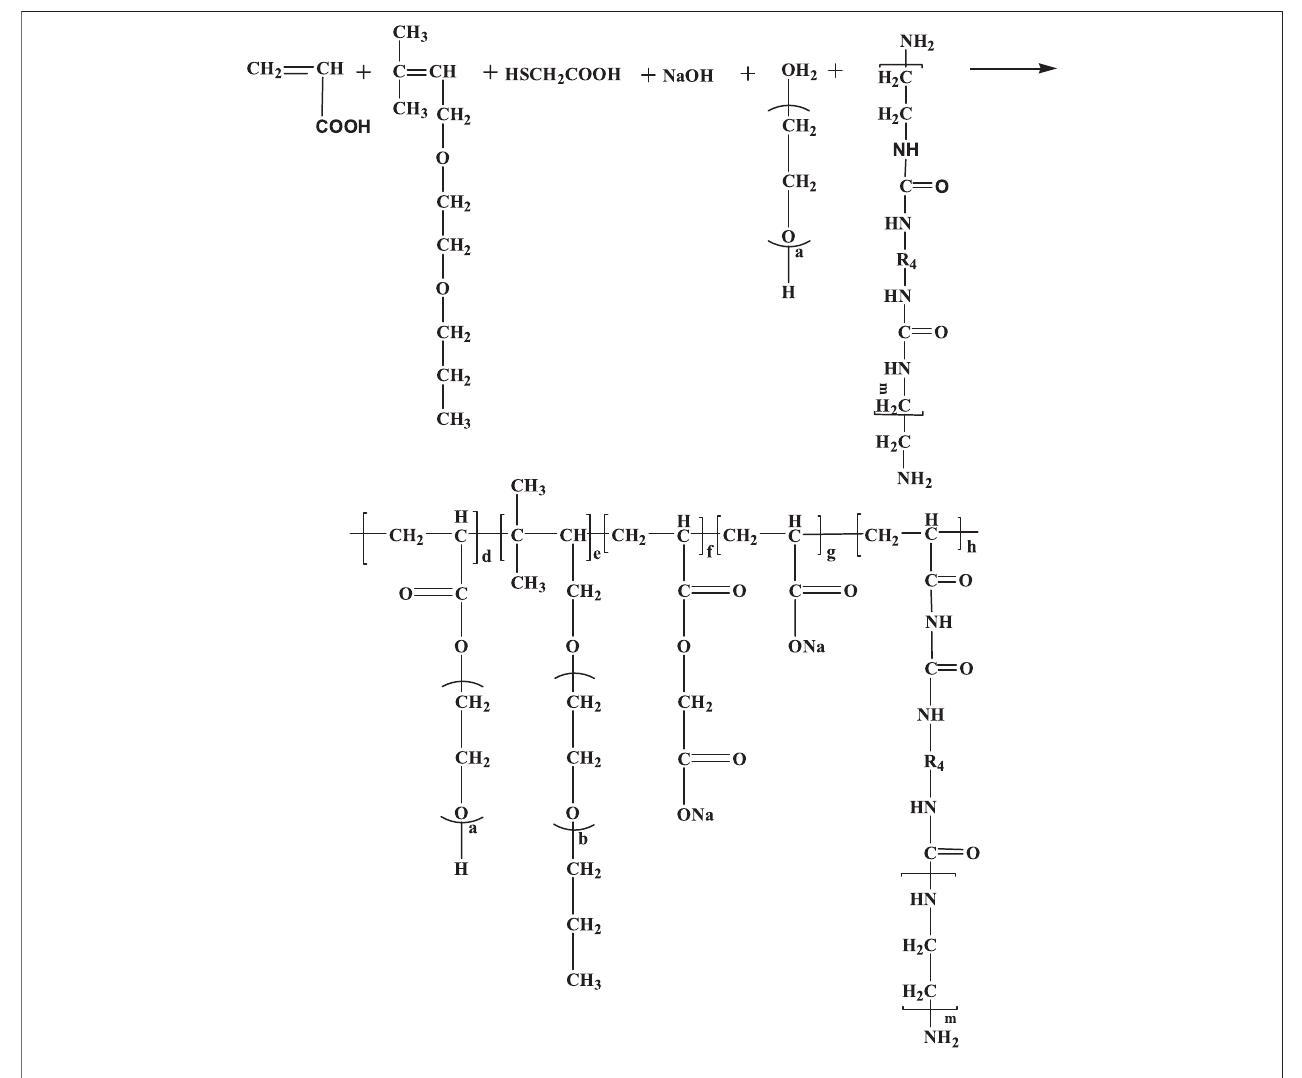
FIGURE 3 | Radical polymerization reactions and chemical structure of (M-PCE).